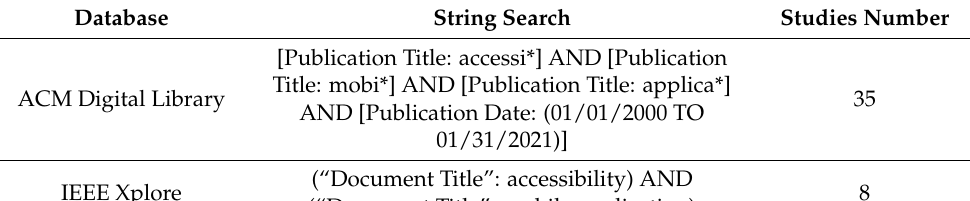
Table 2. Query string applied.